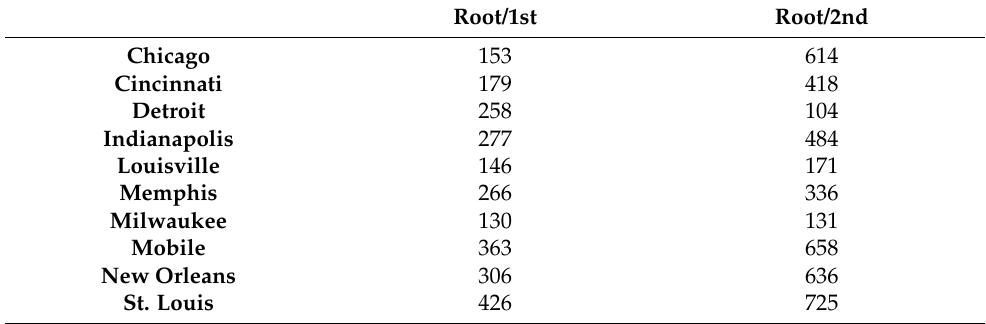
Table 3. Mean Migration Distance (MMD) by Generation Pair from those born in these Cities in 1850—Females Only (in